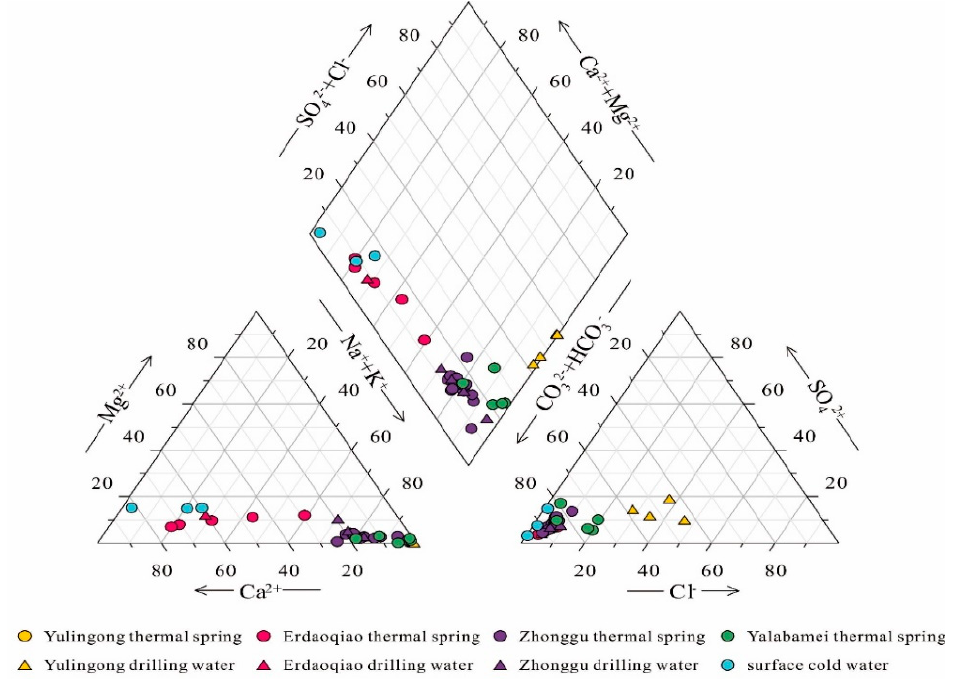
Figure 3. Piper plots of selected cold waters and geothermal waters in the Xianshuihe fault zone (XFZ) [27].